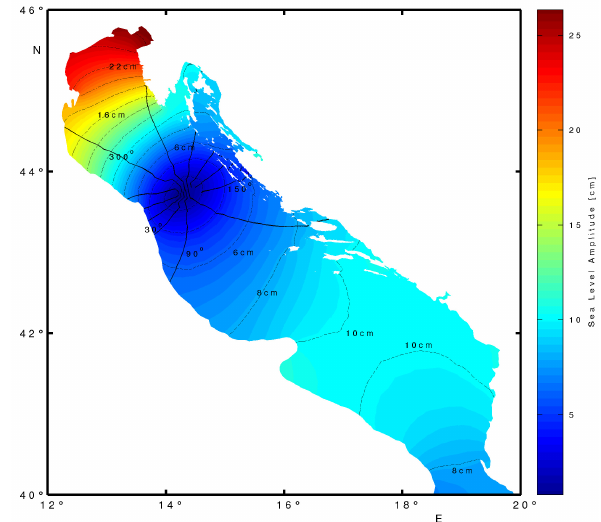
Fig. 5. Co-amplitude and co-phase chart for M2 tidal constituent. Amplitudes are in cm (thin dashed line with 2-cm increment) and phases (line with 30 ◦ increment) in degrees relative to 15 ◦ E.